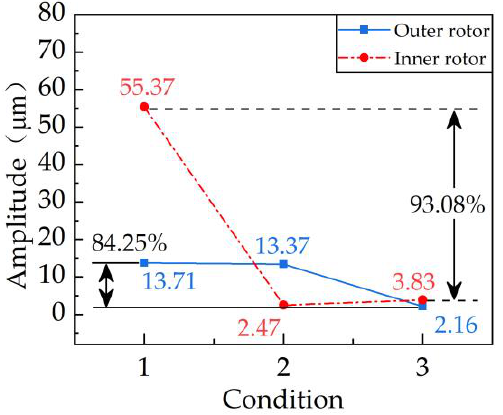
Figure 14. Vibration suppression effect under the condition of slight differential speed. The horizontal coordinate 1 represents the initial state, the horizontal coordinate 2 represents the dynamic balance of the inner rotor, and 3 represents the dynamic balance of the outer rotor.